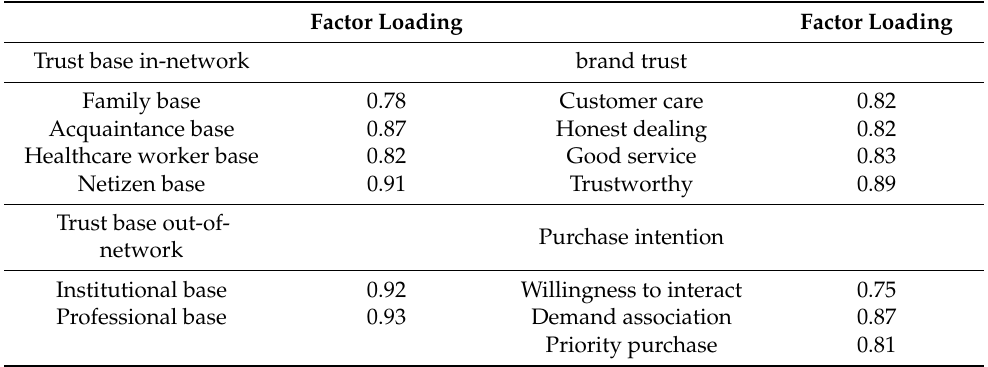
Table 2. Factor loadings for each dimension.